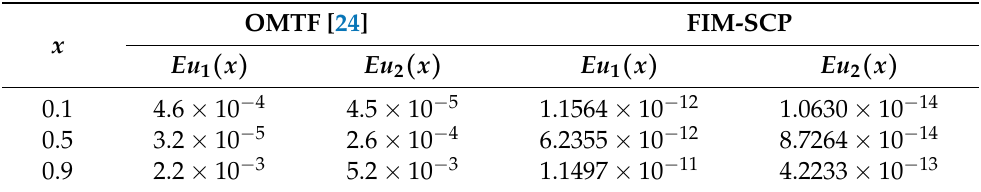
Table 3. Absolute errors of u 1 ( x ) and u 2 ( x ) when α 1 = α 2 = 2 for Example 2.